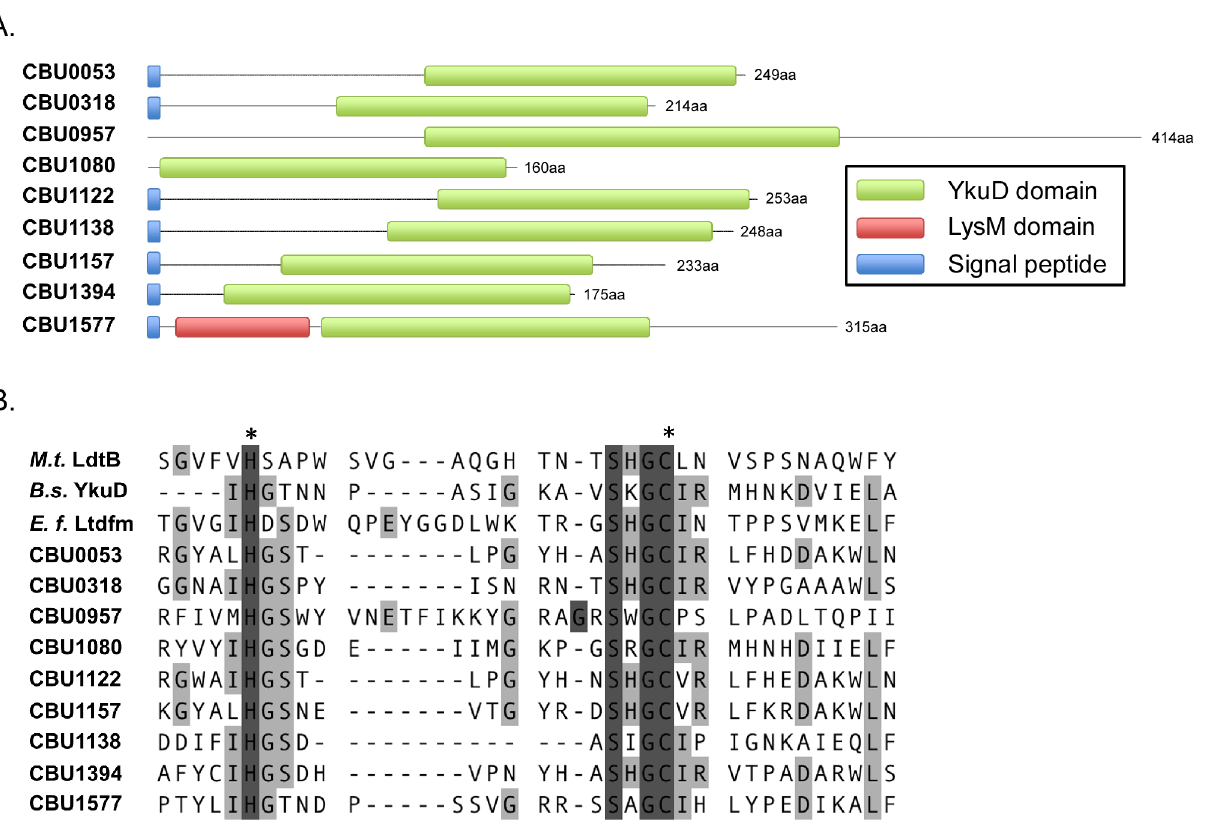
Fig 4. YkuD family proteins of C . burnetii . (A) Schematic showing location of YkuD domains. Location of signal peptides, predicted by SignalP 4.1, and the LysM domain of CBU1577 are also depicted. (B) Amino acid sequence lineup of the predicted catalytic domains of C . burnetii YkuD family proteins with M . tuberculosis LdtB, E . faecium Ltd fm , and B . subtilis YkuD. Invariant histidine and cysteine proposed as catalytic residues are indicated with asterisks